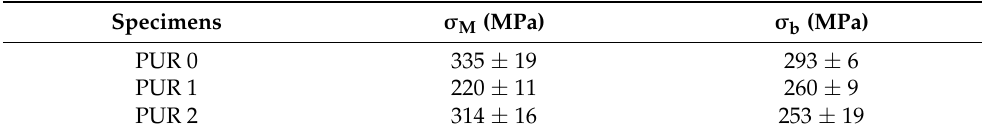
Table 2. Mechanical properties of